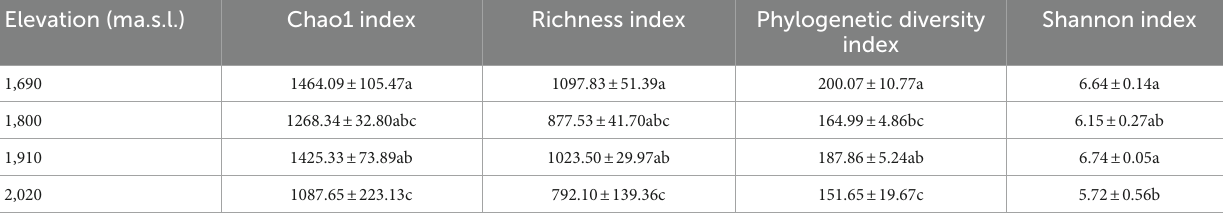
TABLE 2 Fungal alpha diversity along an elevational gradient on the Changbai Mountain, northeastern China 1 . Elevation (m